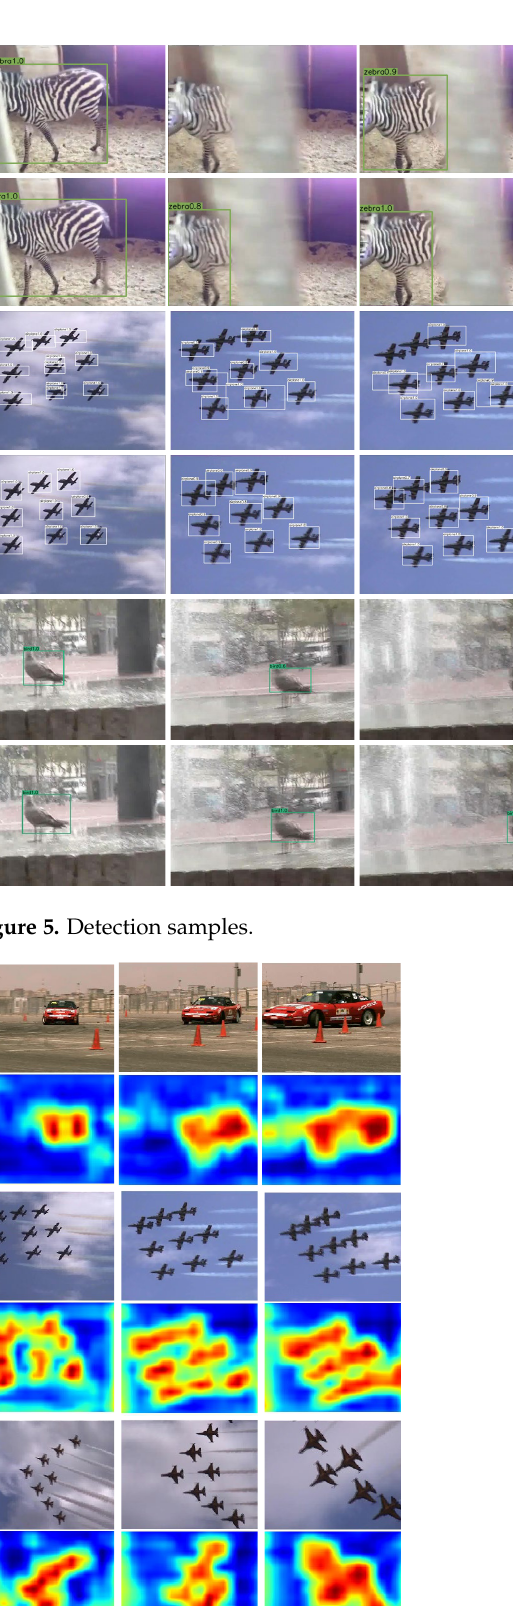
Table 2. Ablation results.